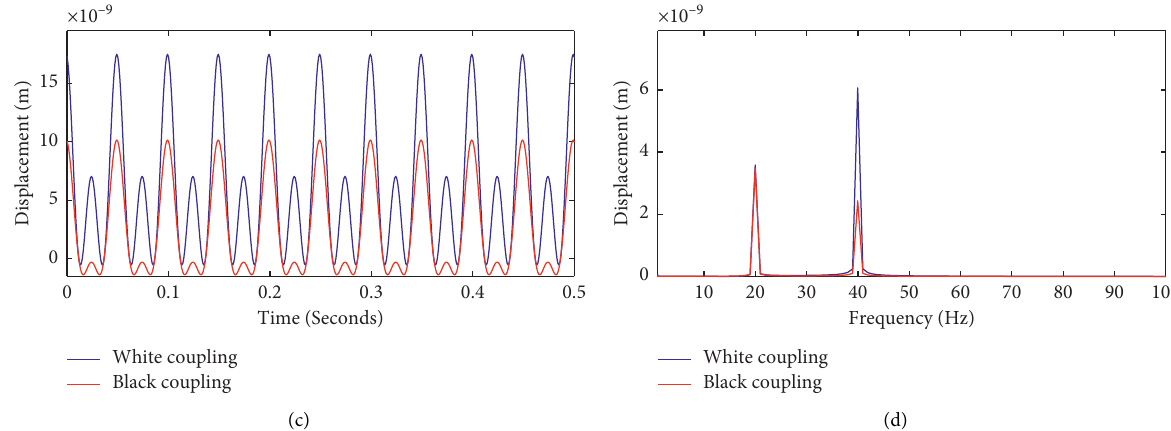
Figure 24: Effects of changing the coupling type in the y direction for a system with imbalance and parallel misalignment. (a) Time response of y1. (b) Frequency response of y1. (c) Time response of y2. (d) Frequency response of y2.